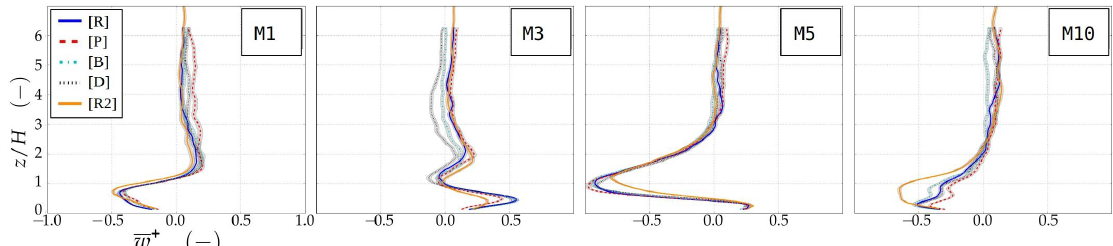
Figure 10. Normalized vertical velocity profiles obtained from each modified model simulation at selected virtual tower